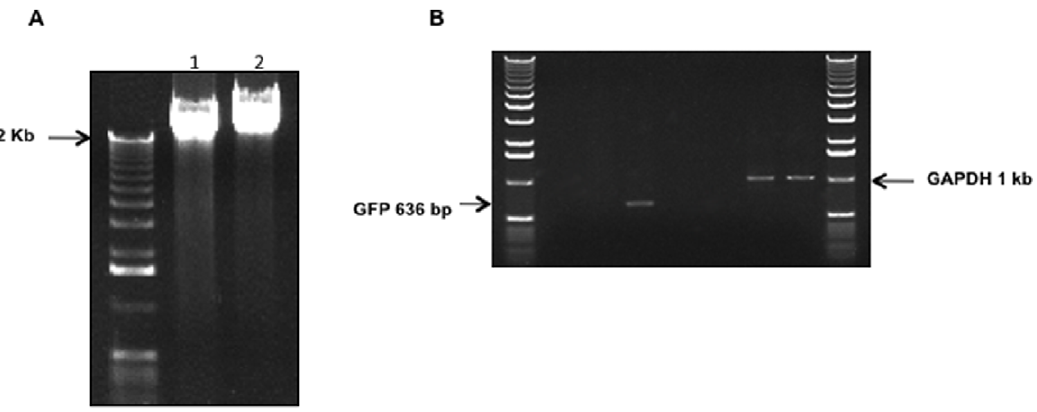
Figure 4. Detection of GFP-coding sequences within genomic DNA prepared from terminally differentiated PC12 cells transduced with RT43.2GFP vectors. A . Representative gel picture showing genomic DNA fragment with size . 10 Kb was used for PCR analysis. Differentiated PC12 cells (5 days with NGF treatment) were exposed to RT43.2GFP vectors for 3 days, and then genomic DNA was isolated and run on a 0.8% agarose gel to purify DNA fragment with size . 10 Kb. (lane 2). Non-transduced PC12 cells were used as a negative control as represented by